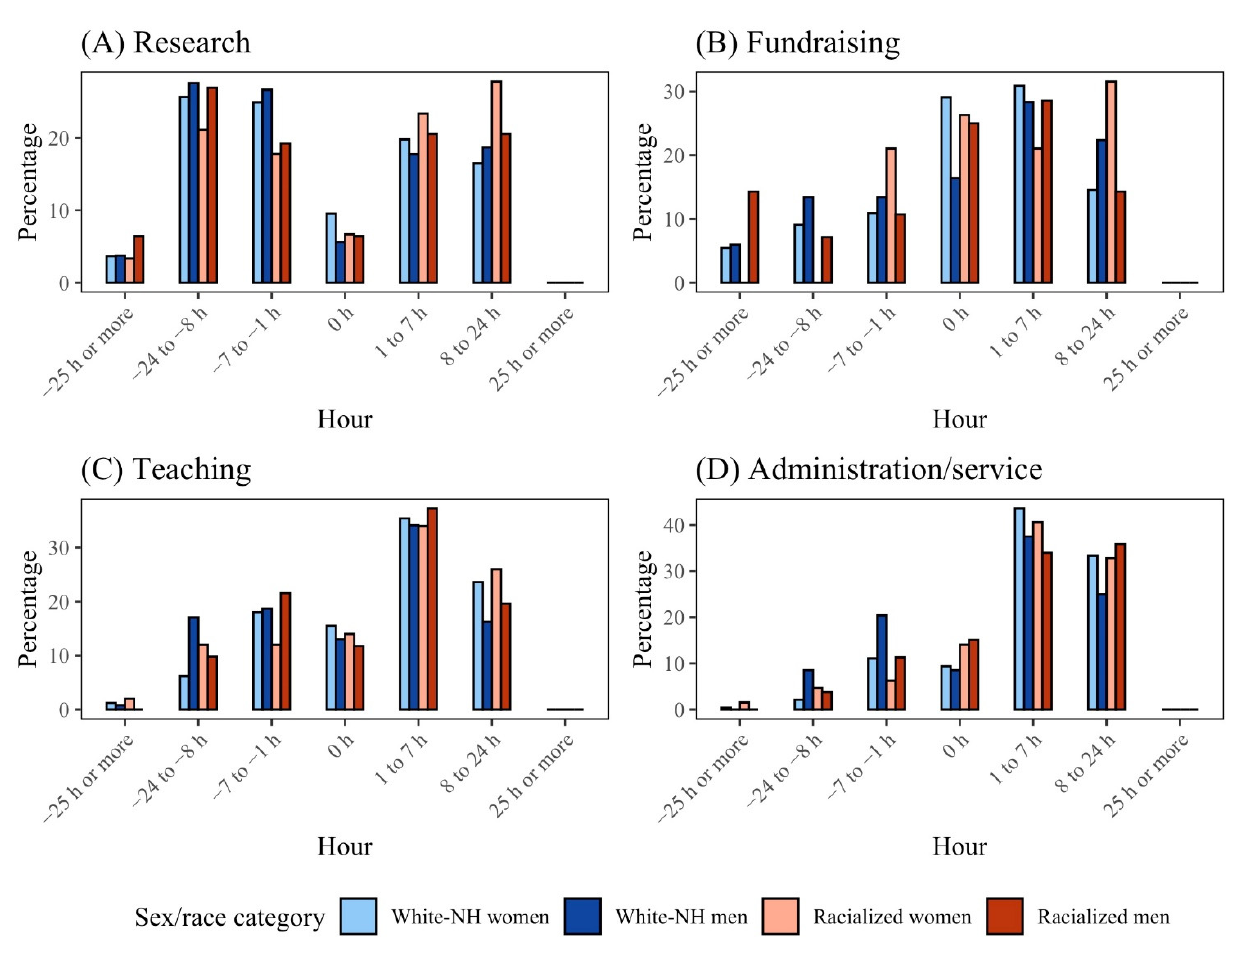
Figure 2. Changes in the work hours (per week) for different form of academic and scientific labor by gender and race/ethnicity: ( A ) research; ( B ) fundraising; ( C ) teaching; ( D ) administration/service. Note. NH = non-Hispanic.